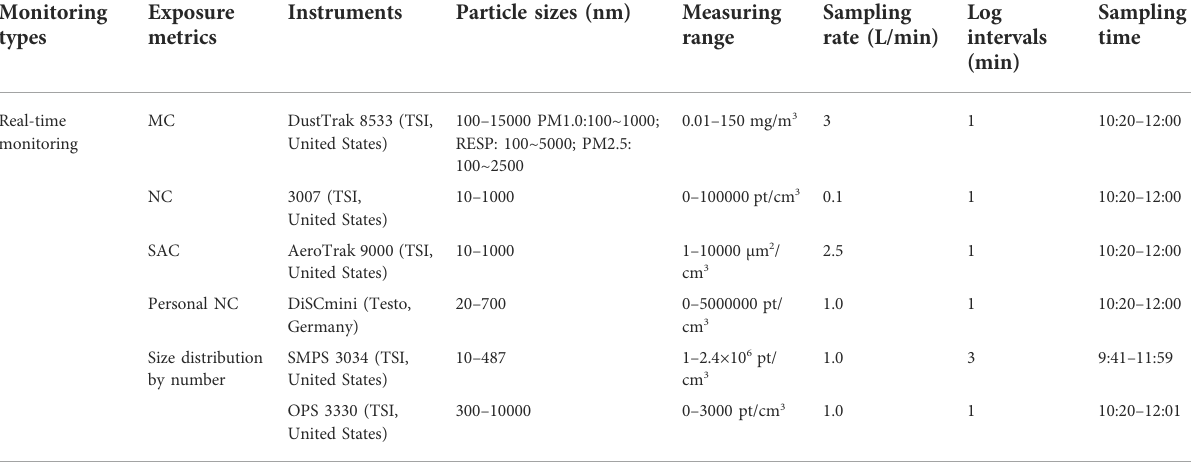
TABLE 1 Measuring systems for monitoring the concentrations and size distribution of the submicron particles.